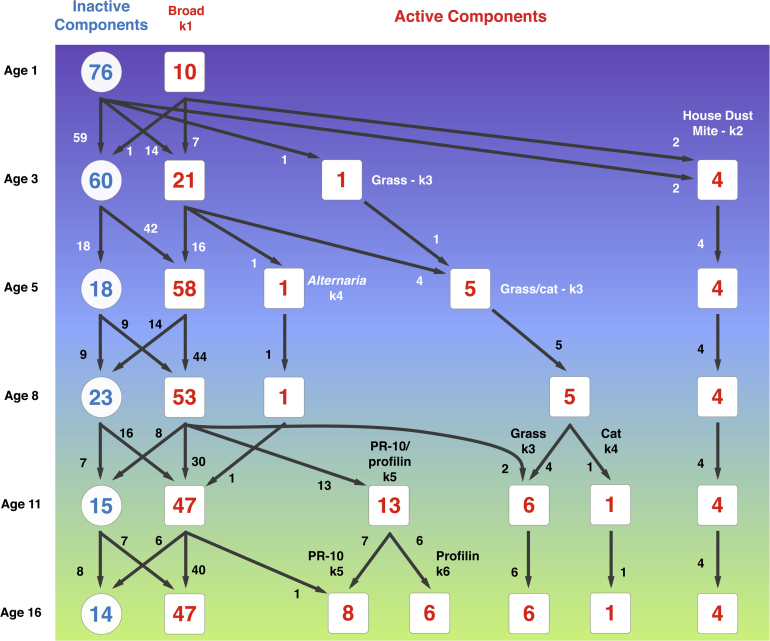
Clustering active IgE components throughout childhood. Cluster membership was determined using a Bernoulli mixture model applied to binarized sensitization data from all subjects.